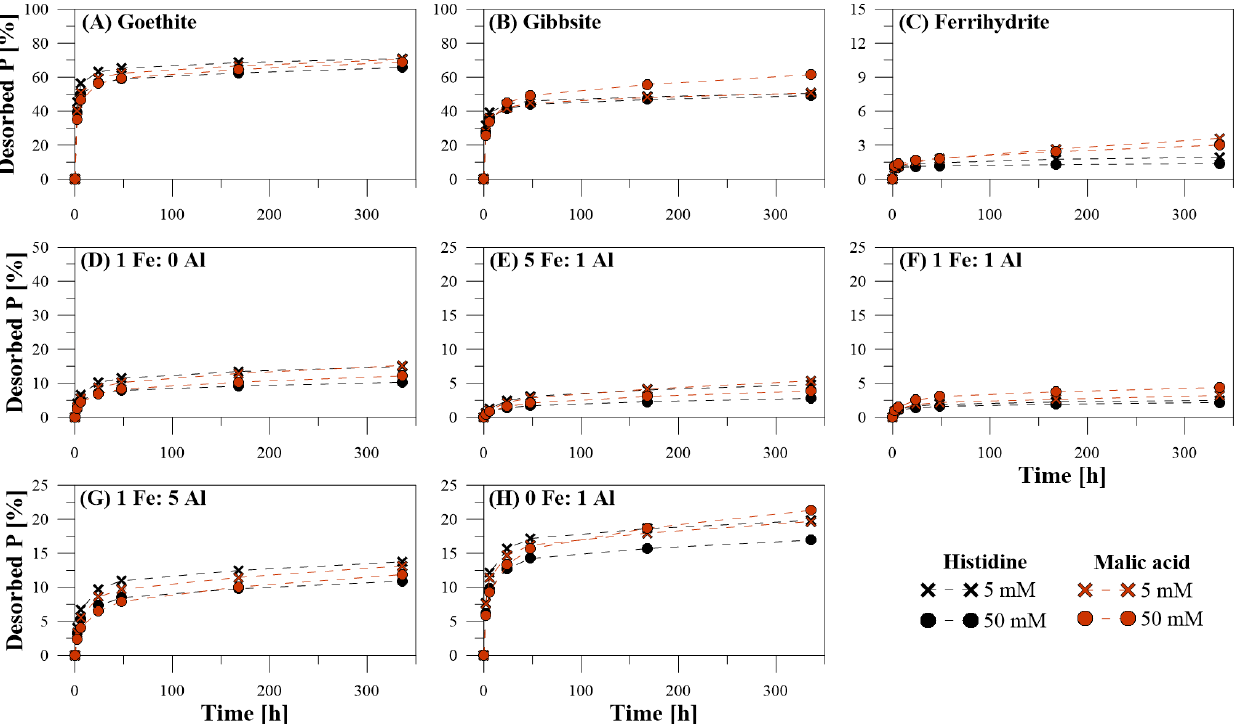
Figure 2. Kinetics of P desorption from ( A ) goethite, ( B ) gibbsite, ( C ) ferrihydrite, ( D ) 1 Fe: 0 Al, ( E ) 5 Fe: 1 Al, ( F ) 1 Fe: 1 Al, ( G ) 1 Fe: 5 Al, ( H ) 0 Fe: 1 Al with histidine and malic acid at concentrations of 5 mM and 50 mM.